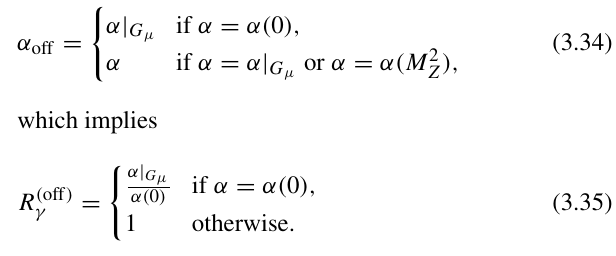
values M W = 80 . 399GeV, M Z = 91 . 1876GeV and Γ W = Γ Z = 0. For the weak mixing angle, sin 2 θ w = 0 . 22262651564387248 in all ) = three schemes, while the derived value of α | G μ is reported in the Z